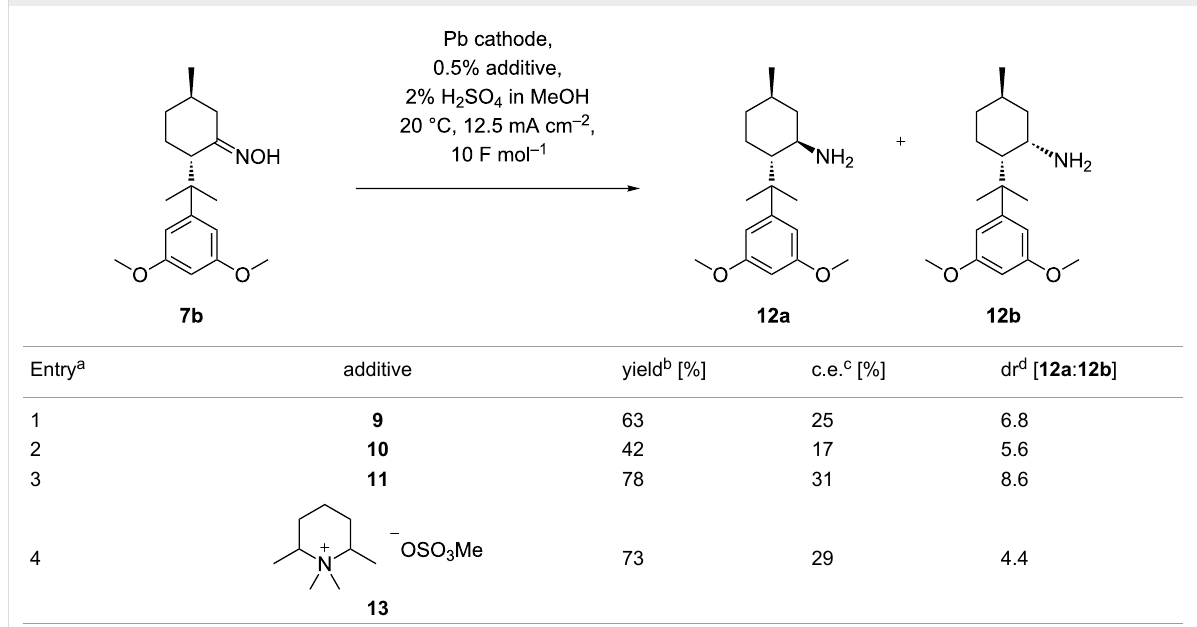
Table 3: Electrochemical synthesis of 12a using different additives.